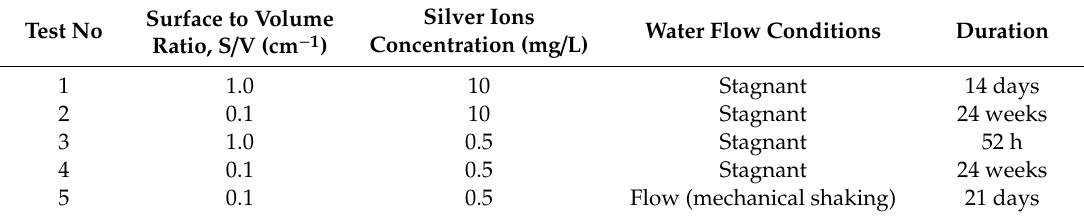
Table 1. Experimental conditions of the exposure of SS316L passivated, SS 316L passivated + electropolished and Titanium (Ti-6Al-4V) solid